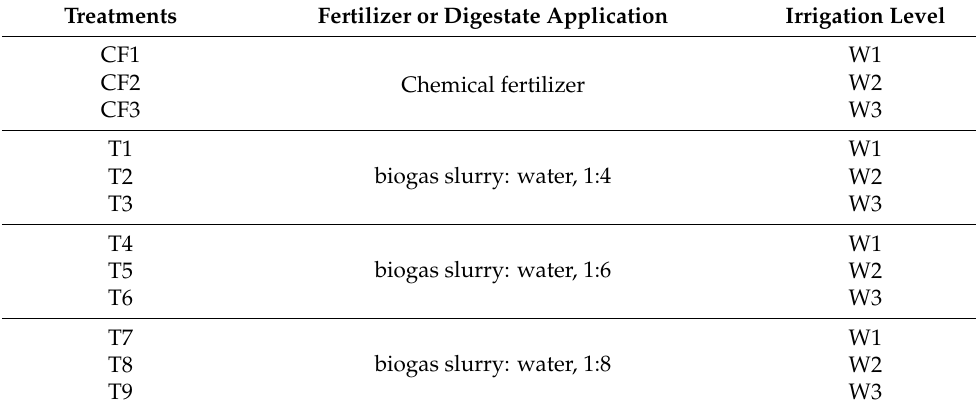
Table 1. Experimental scheme for irrigation.